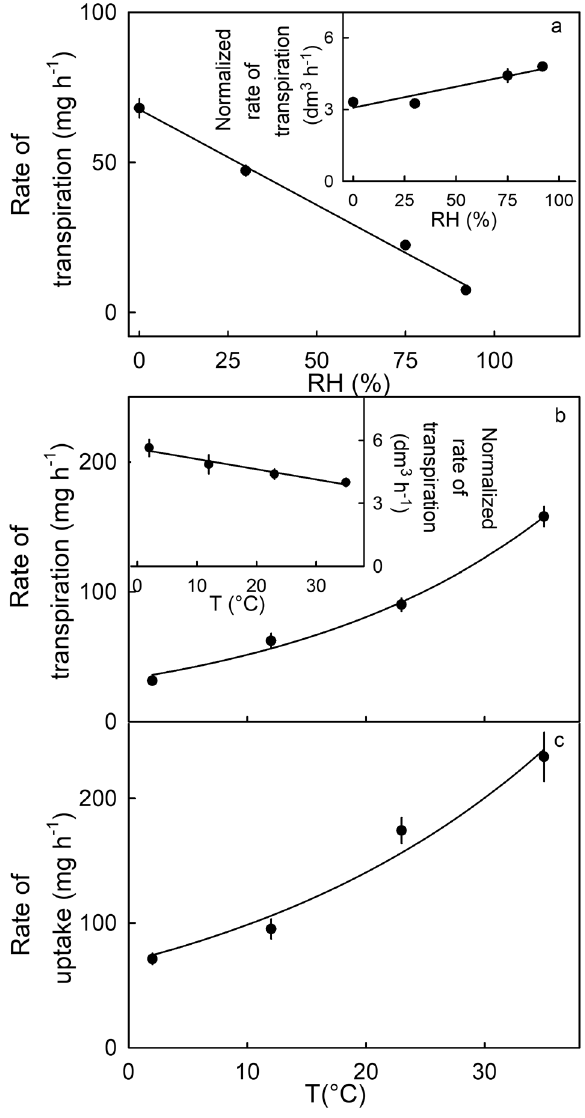
Figure 7. ( a ) Effect of relative humidity (RH) on the rate of transpiration (main graph) and on the normalized rate of transpiration (inset). ( b ) Effect of temperature (T) on the rate of transpiration (main graph) and on the normalized rate of transpiration (inset) and ( c ) on the rate of water uptake of ‘Laetitia’ strawberry. Normalized transpiration rates were calculated by dividing the rate of transpiration by the difference in water vapor concentration between the inside of the fruit 20 – assumed to be a saturated atmosphere – and the outside atmosphere above dry silica gel – assumed to be 0 g m −3